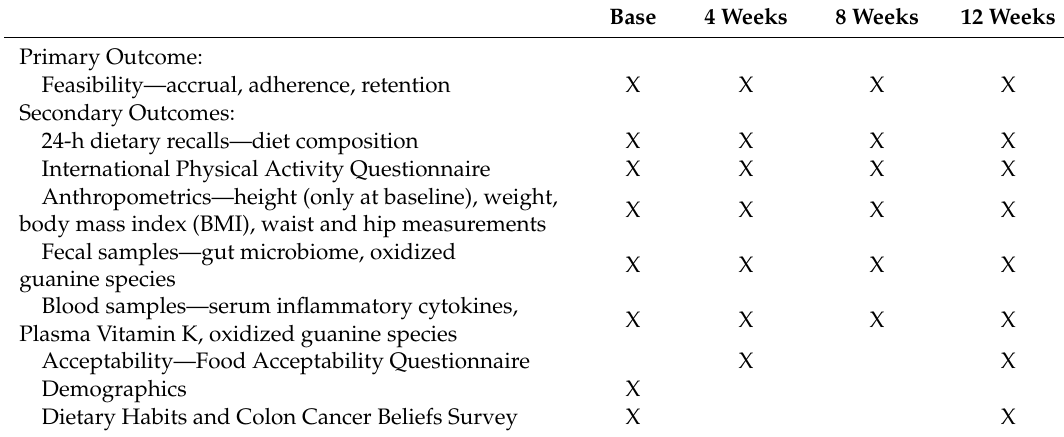
Table 1. Timeline and measures for a randomized controlled crossover high green leafy vegetable dietary intervention.